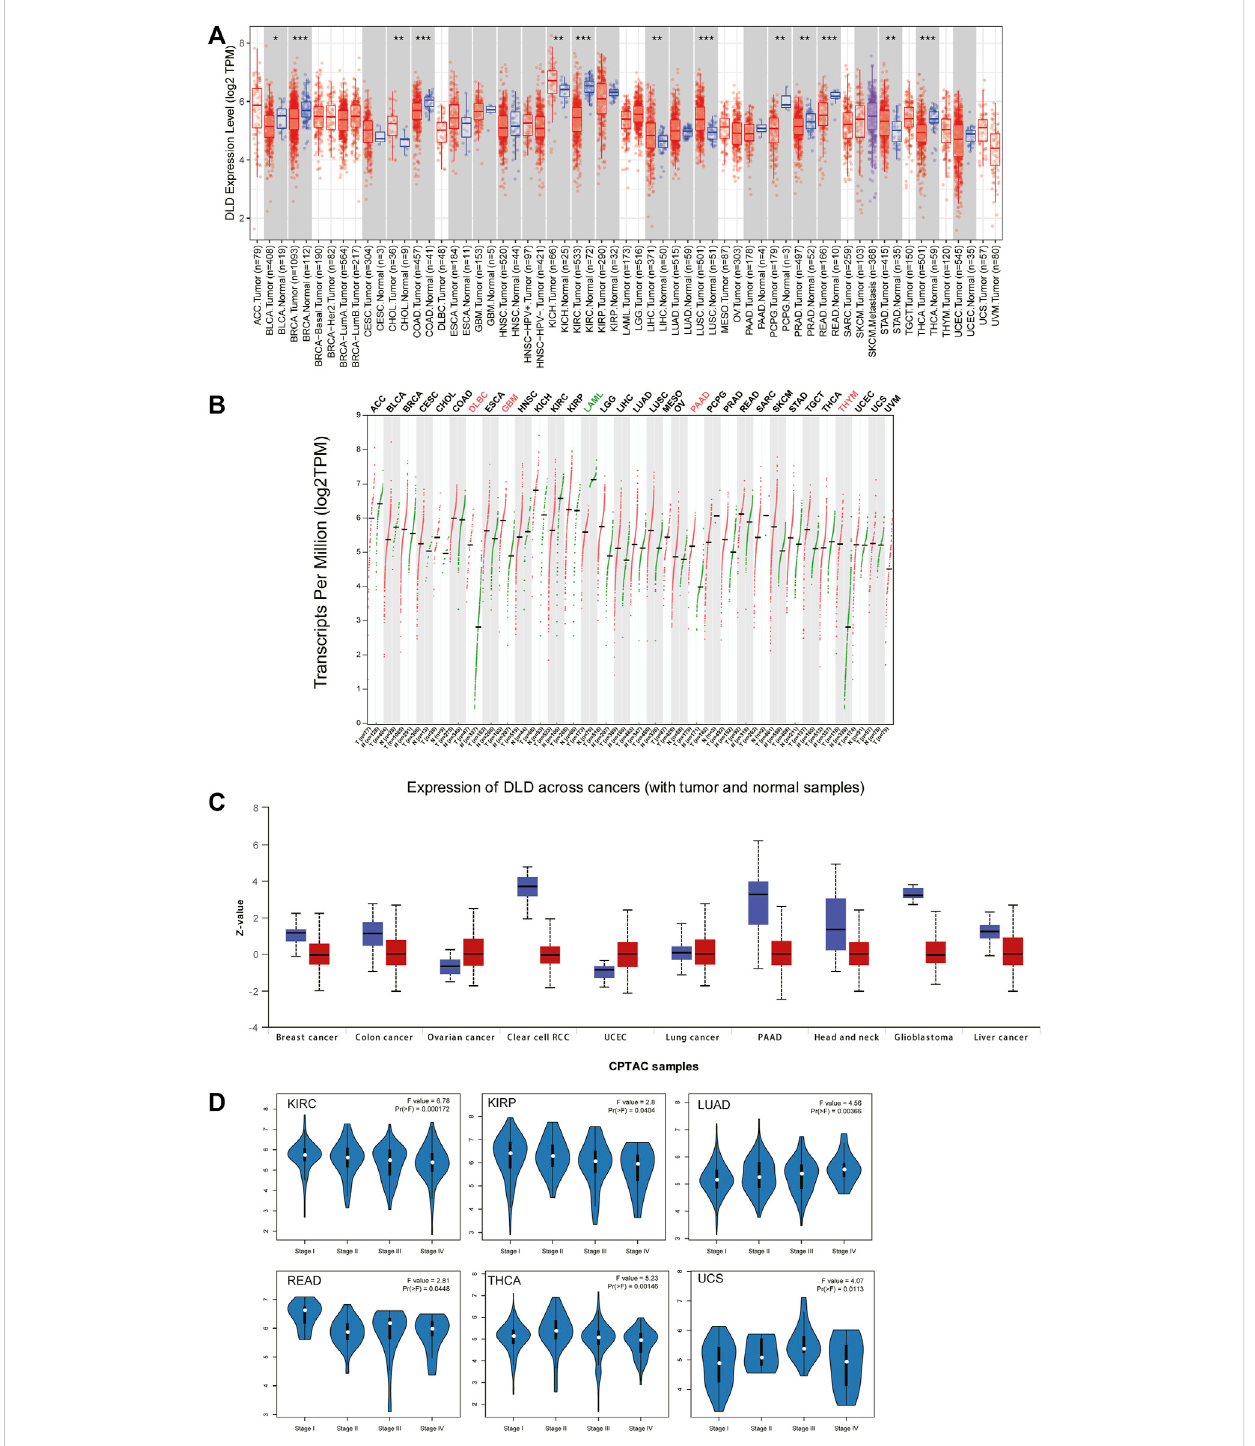
FIGURE 2 DifferentialexpressionofDLDacrosscancers. (A) mRNAlevelofDLDdeterminedwiththeTIMER2.0database.*** p < 0.001;** p < 0.01;* p < 0.05. (B) mRNA level of DLD determined with the GEPIA2.0 database. (C) Protein level of DLD determined with the CPTAC database. (D) Violin plots showing the relationship between the DLD expression level and pathological